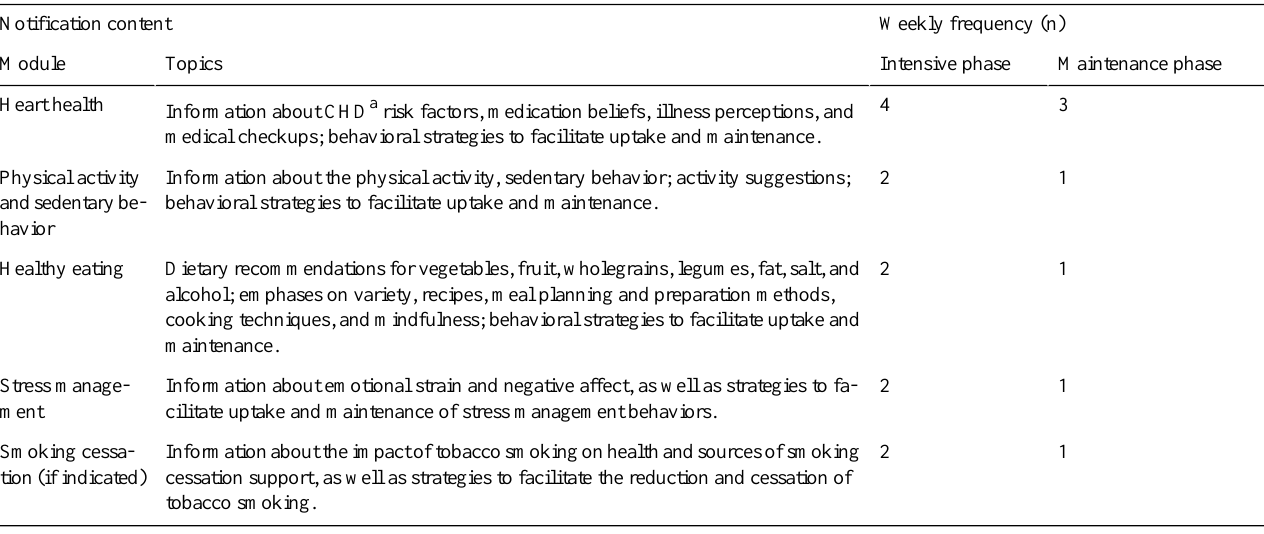
Table 1. Outline of self-management behavioral support